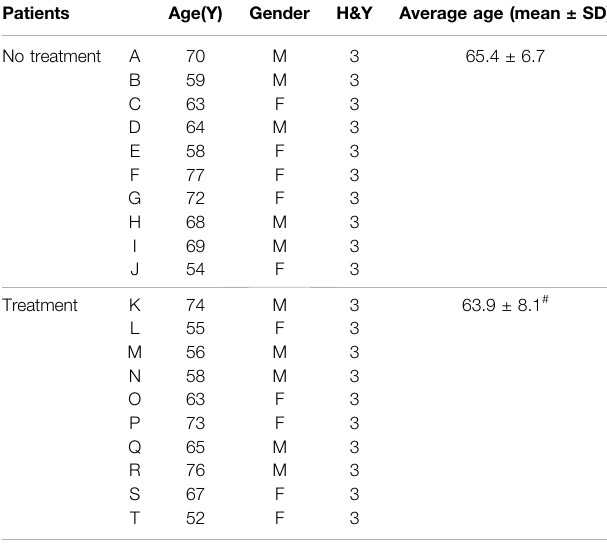
TABLE 2 | The information of PD patients with a 3 – 5 year duration between the treatment and no treatment groups.